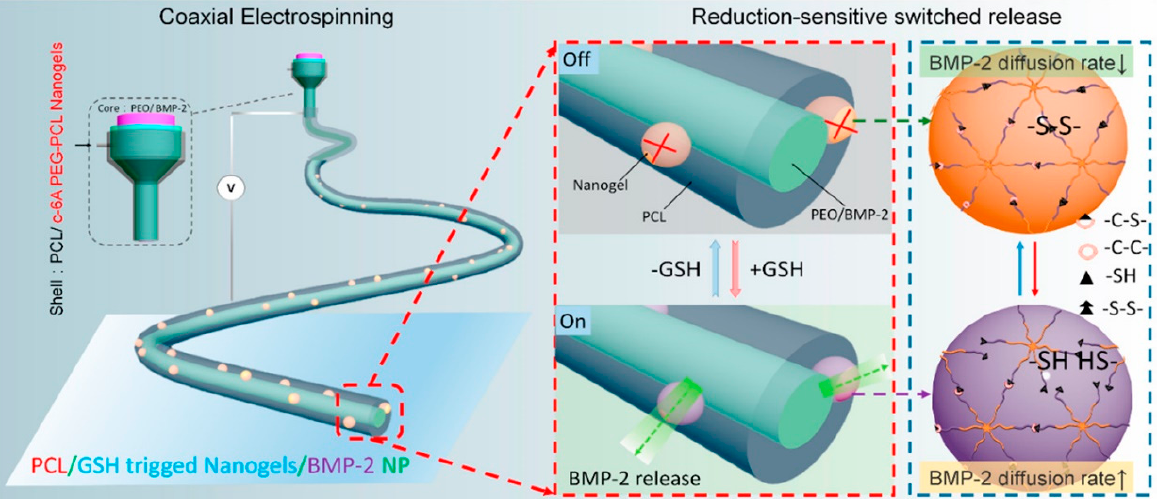
Figure 5. Schematic illustration of the fabrication of a nanogel-in-nano fi ber device with coaxial elec- trospinning and the redox-responsive release with the nanogel. Reprinted with permission from [84].